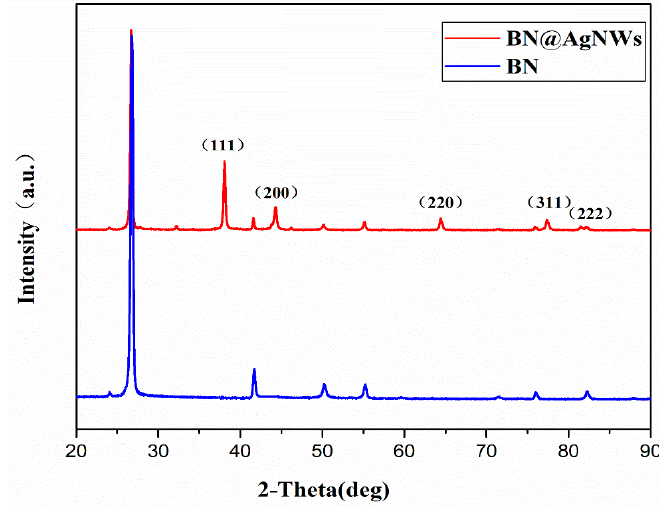
Figure 3. XRD patterns of BN and BN@AgNWs hybrid fillers.